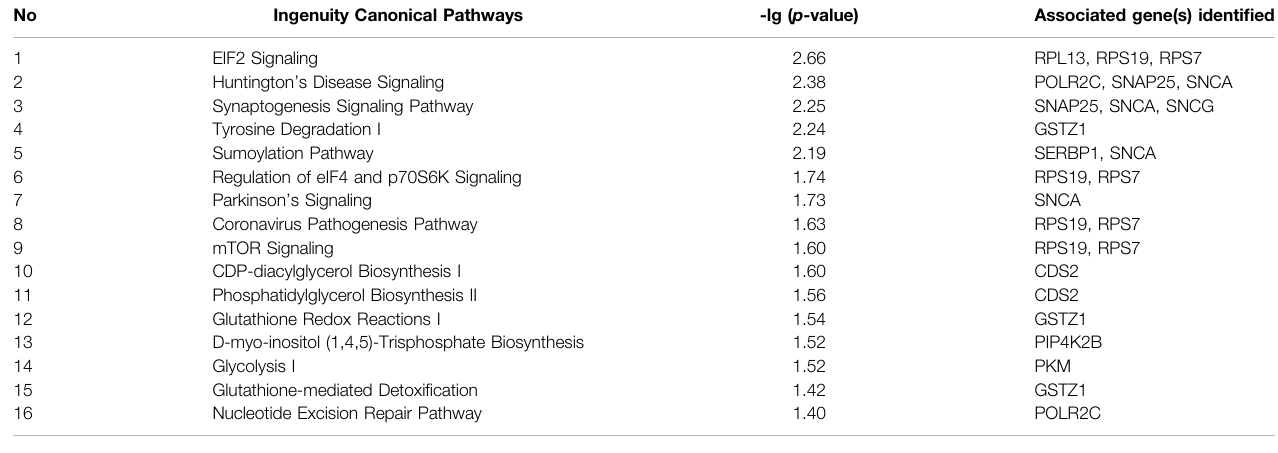
TABLE 2 | Sixteen signi fi cant pathways with associated proteins were predicted by IPA from 29 differentially expressed proteins using iTRAQ and SWATH analysis. Criteria for signi fi cant pathways were as -lg ( p -value) ≥ 1.3 ( p -value < 0.05), Fischer ’ s exact test. No